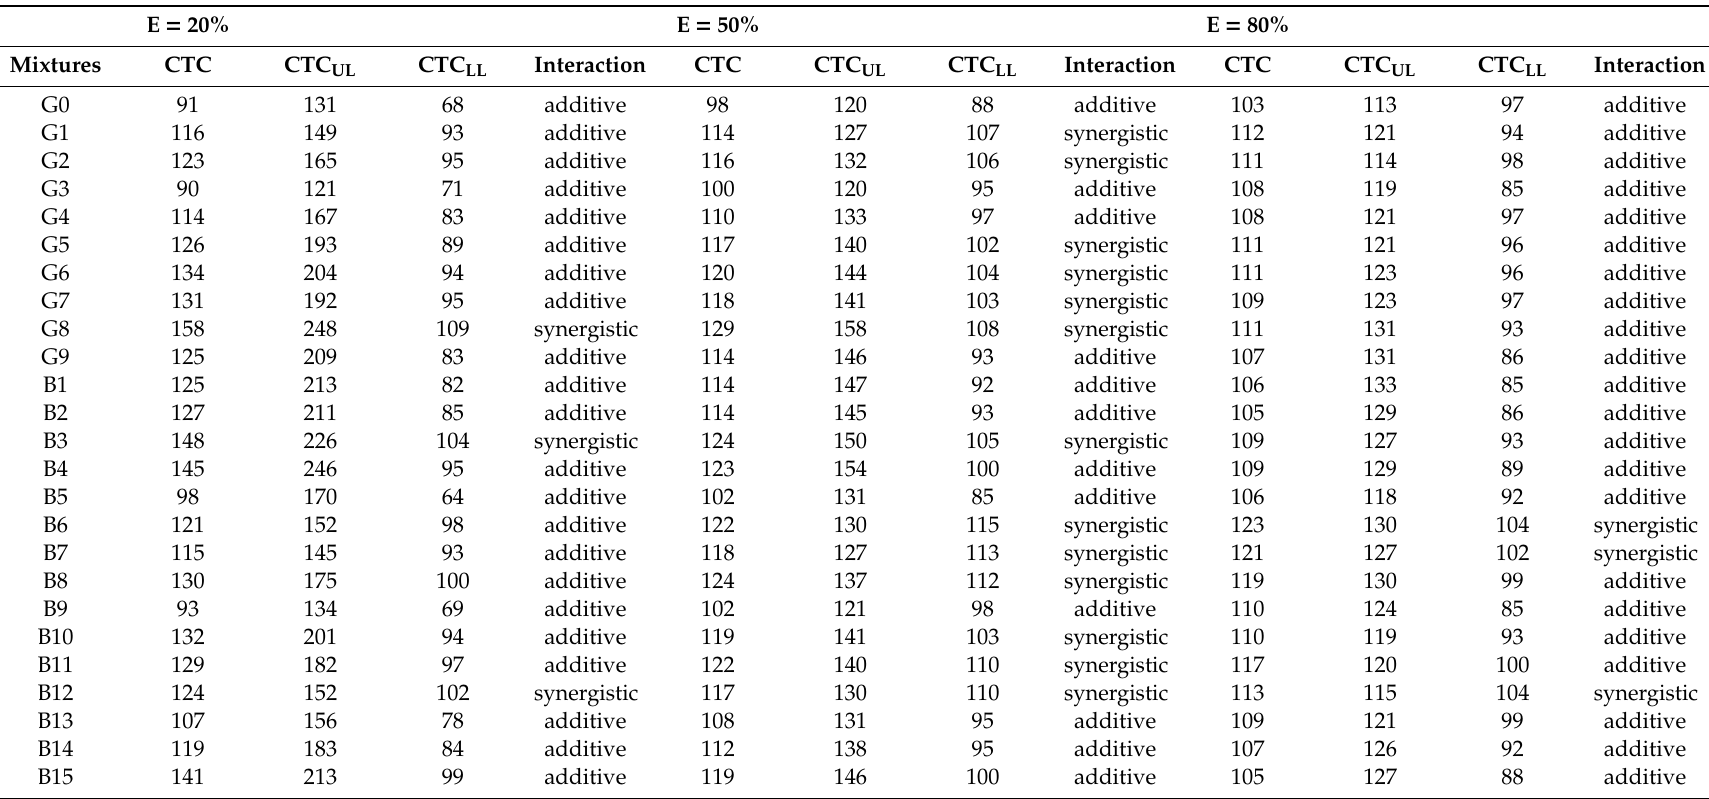
Table 2. Joint toxicity e ff ect of [BMIM]BF 4 , [BMIM]PF 6 , and [HMIM]BF 4 on